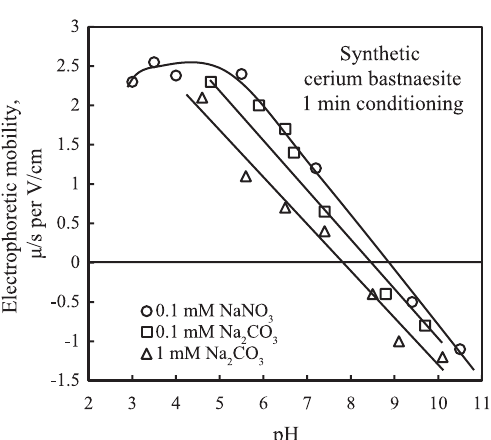
Fig. 4 Electrophoretic mobility of synthetic cerium bastn- aesite as a function of pH in the presence and absence of sodium carbonate (24 hour conditioning).